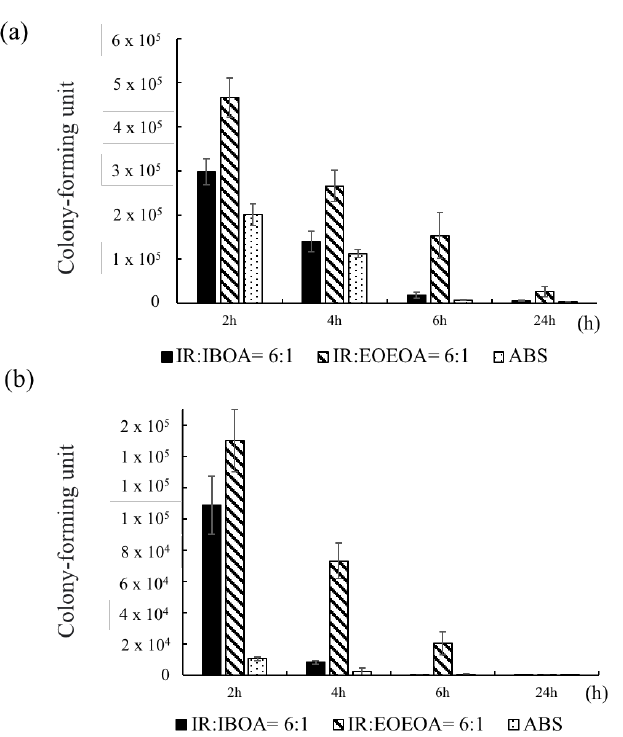
Figure 7. The H. pylori adhesion effect with and without plasma treatment in different time under a shaking of 50 rpm in the pH 2 environment. ( a ) H. pylori adhesion effect on resin and ABS with plasma treatment. ( b ) H. pylori adhesion effect on resin and ABS without plasma treatment.